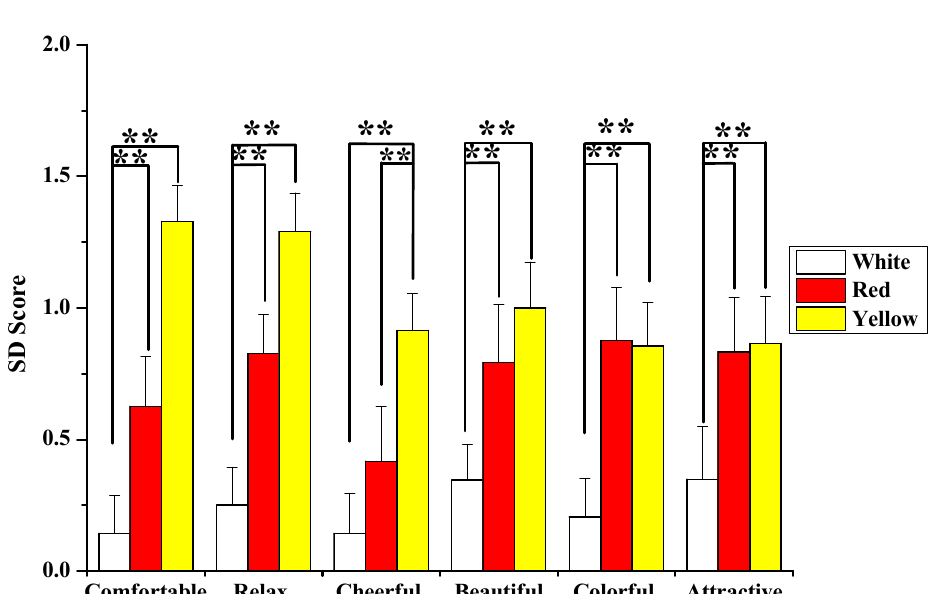
Figure 9. The participants’ emotions after viewing white, red, and yellow flowers, as measured by the semantic differential questionnaire. ** p < 0.01, using the Wilcoxon signed-rank test.